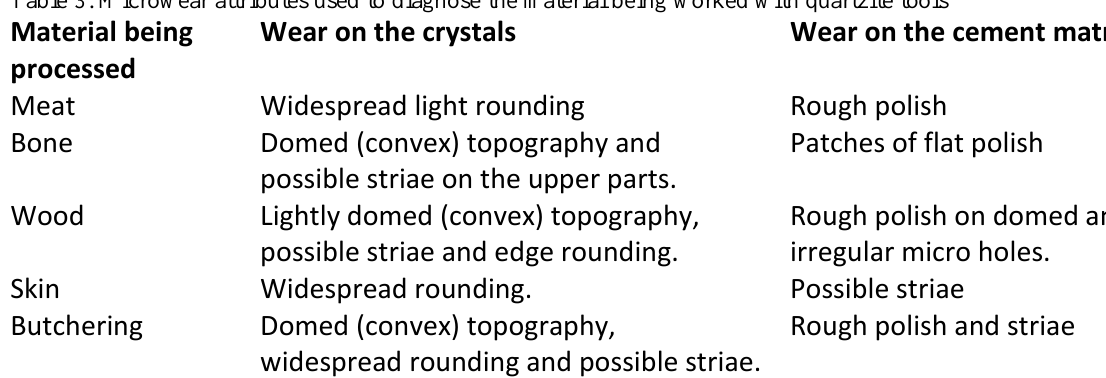
Table 3. Microwear attributes used to diagnose the material being worked with quartzite